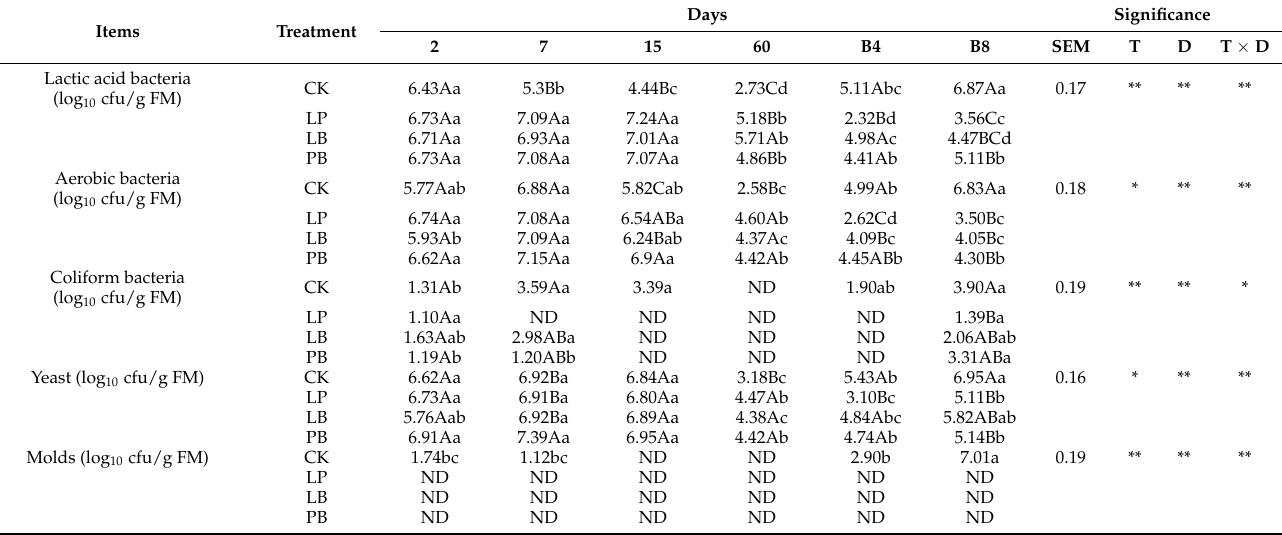
Table 4. Effects of additives and days of anaerobic fermentation and aerobic exposure on microorgan- ism counts of native grass